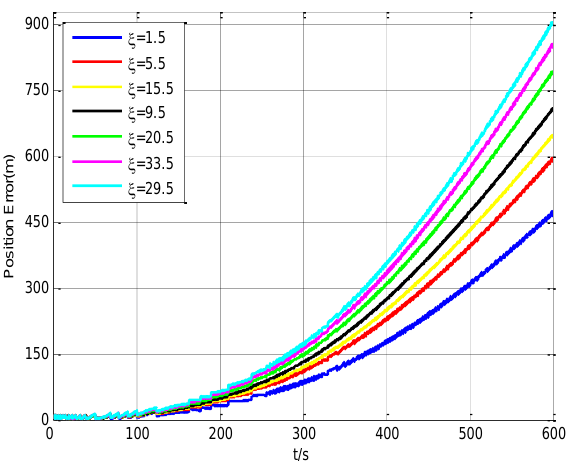
Figure 8. The influence of robustness factors ξ on navigation accuracy.